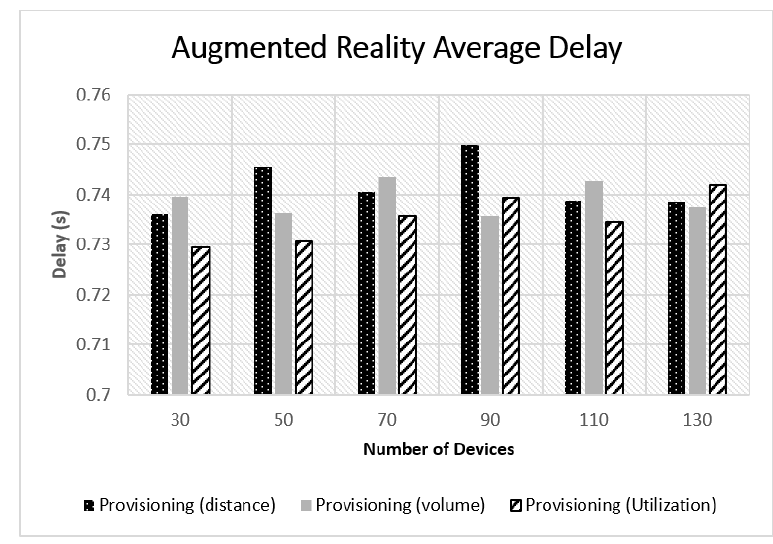
Figure 8. Provisioning-based algorithms